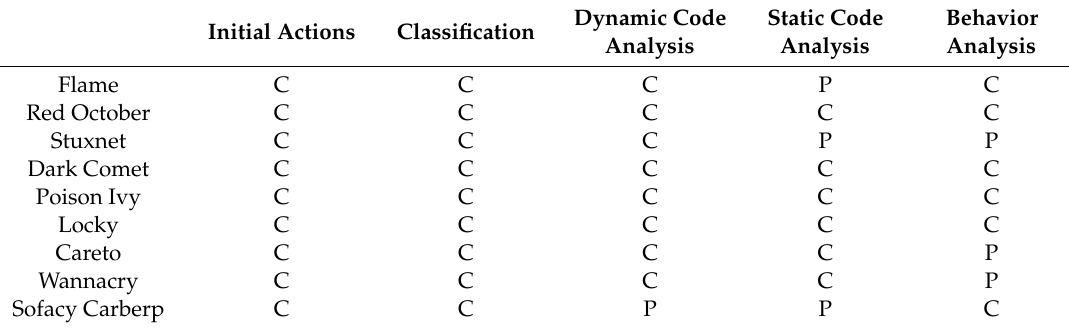
Table 13. Results of the